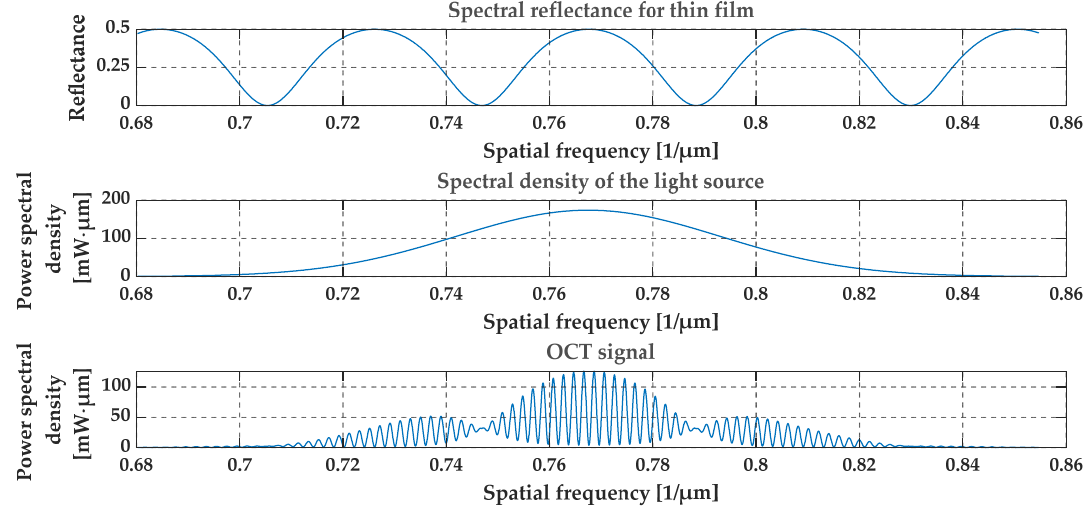
Figure 6. Theoretical spectral characteristics obtained from a thin film of diamond. The thickness of the layer is 5 µm and the depth of the layer is 0.1 mm. Refractive indexes are n 1 = 1, n 2 = 2.4, n 3 = 1.